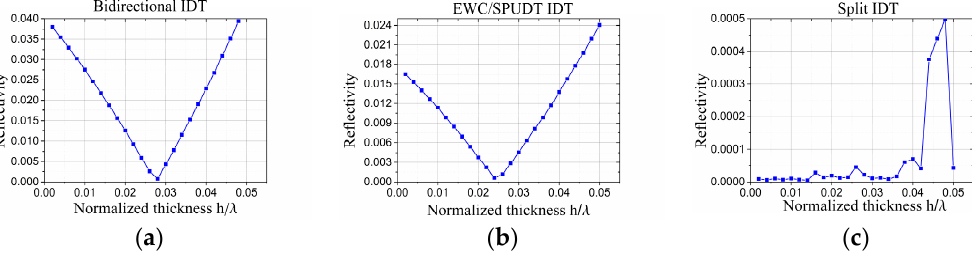
Figure 7. Reflectivity in different types IDTs: ( a ) bidirectional IDT, ( b ) EWC/SPUDT, and ( c ) split IDT.